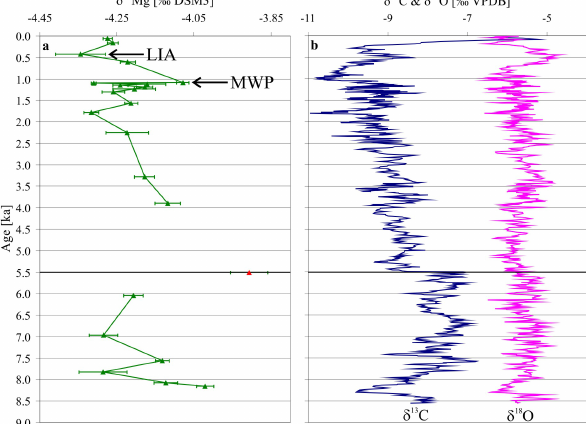
Fig. 5. Magnesium, carbon and oxygen isotope data of the stalag- mite BU 4 from Bunker Cave, Germany. Black line marks hiatus characterized by a coralloid layer and detrital material. (a) Mg- isotope data plotted against age in ka BP. Red triangle indicates sample taken in a detritus layer. (b) Carbon (dark blue) and oxy- gen (magenta) isotope data plotted against age in ka BP (data from Fohlmeister et al., 2012). Samples taken at the time of the Medieval Warm Period (MWP) and of the Little Ice Age (LIA) are indicated with black